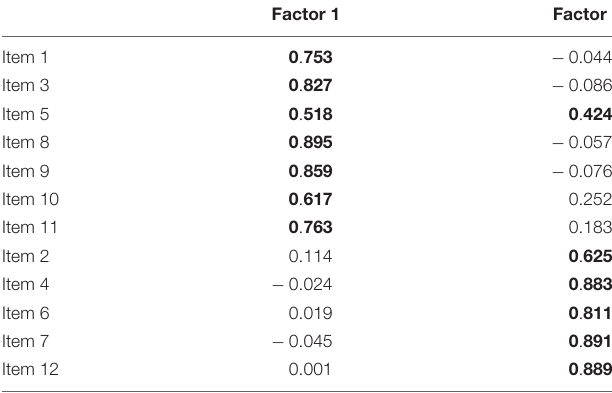
TABLE 2 | Pattern matrix of PAPS items.